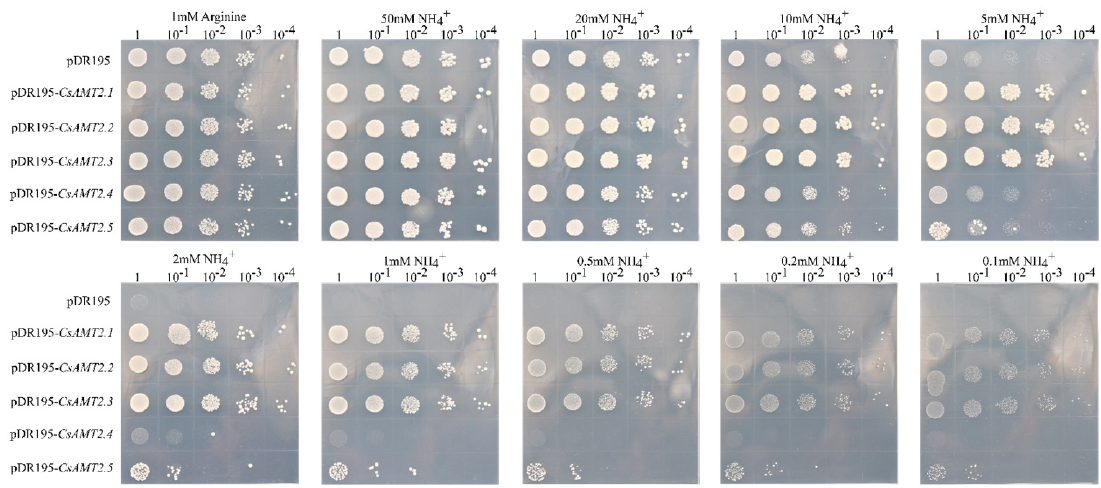
Figure 8. Functional growth complementation analysis of CsAMT2s in ammonium-uptake-defec- tive yeast mutant.